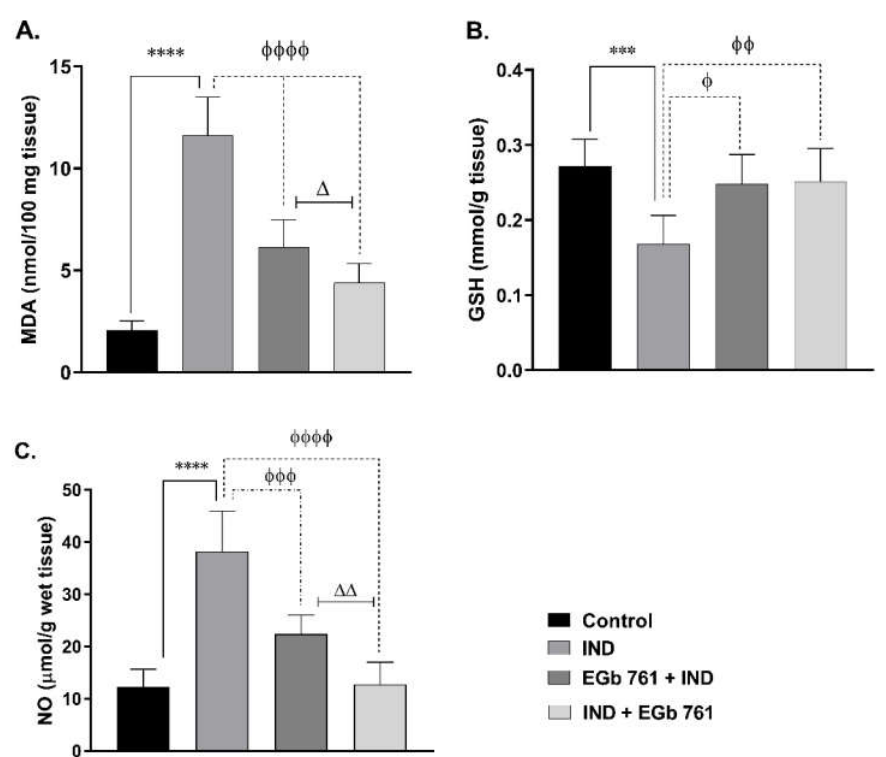
Figure 2. Changes were obtained by the administration of IND and EGb 761 on the gastric MDA tissue levels ( A ), GSH ( B ), and NO ( C ). Data are presented as mean ± SEM (n = 6). *** ( p < 0.001) and **** ( p < 0.0001) significantly different from control. ϕ ( p < 0.05), ϕϕ ( p < 0.01), ϕϕϕ (p < 0.001), and ϕϕϕϕ ( p < 0.0001) significantly different from IND group. Δ ( p < 0.05) and ΔΔ ( p < 0.01) significantly different from EGb 761+ IND (Prophylactic EGb 761) group. IND: Indomethacin; EGb 761: Standardized G. biloba extract.